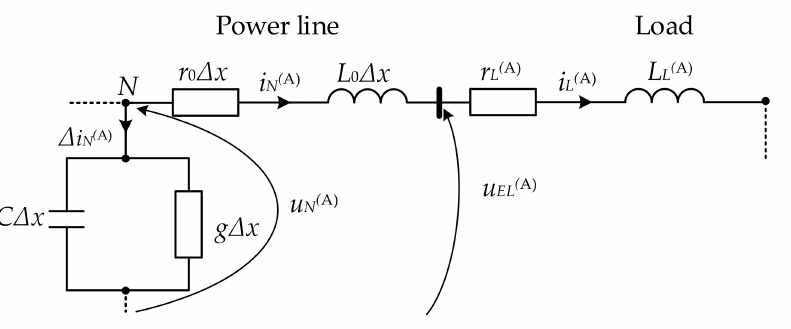
Figure 4. Computing diagram for voltage determination across a fictitious node at the line’s